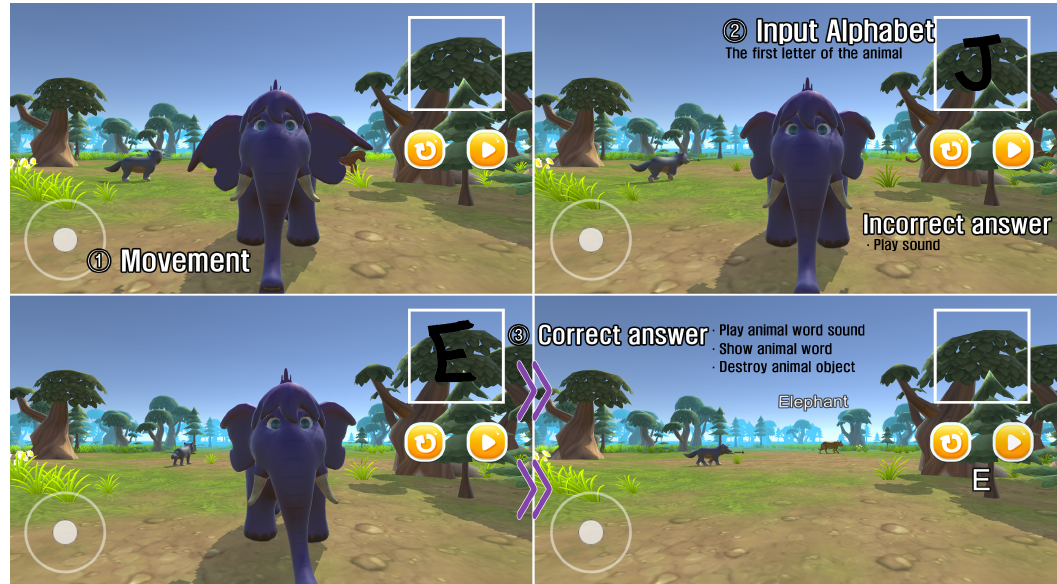
Figure 6. English language teaching process of text-interface-based application